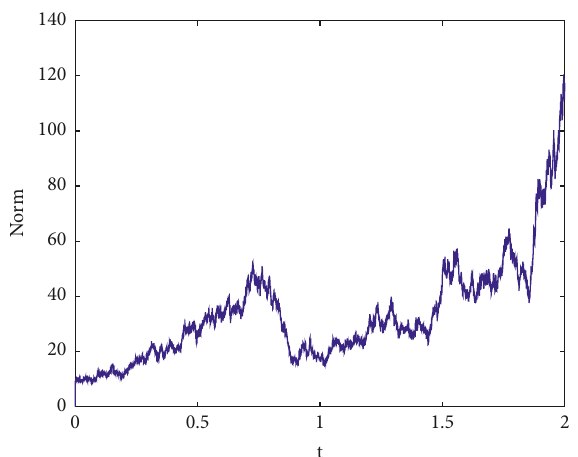
Figure 2: The L 2 ( 0 , 1 ) norm of the sample path of the solution u ( x,t ) to equation (1) without control.